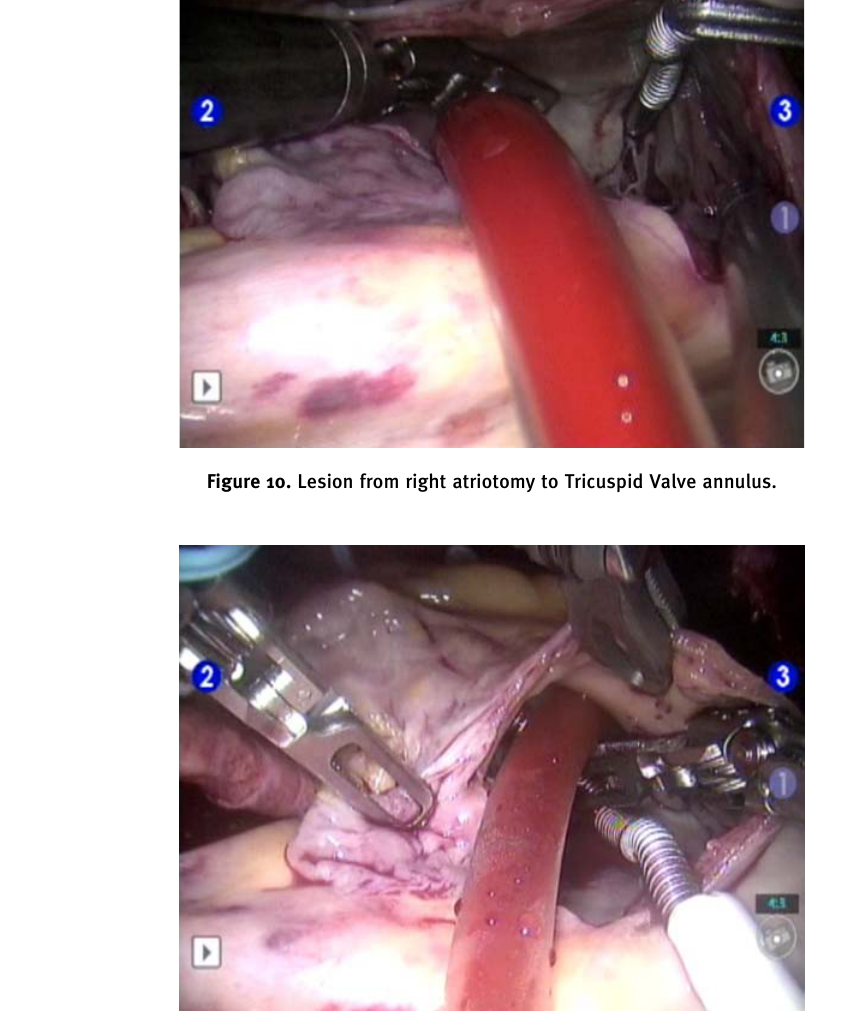
Figure 11. Lesion from Tricuspid Valve annulus to Right Atrial